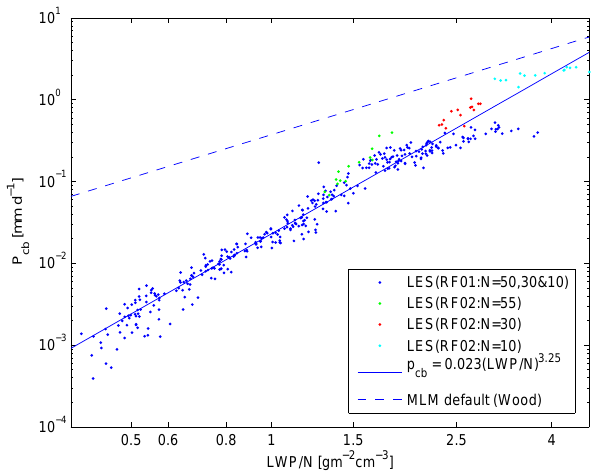
Fig. 6. LES cloud base precipitation rate vs. LWP/ N . Dots indicate hourly averages from the 4 LES cases; blue line indicates the power law fit of Eq. (9), and the red dashed line shows the default MLM parameterization.